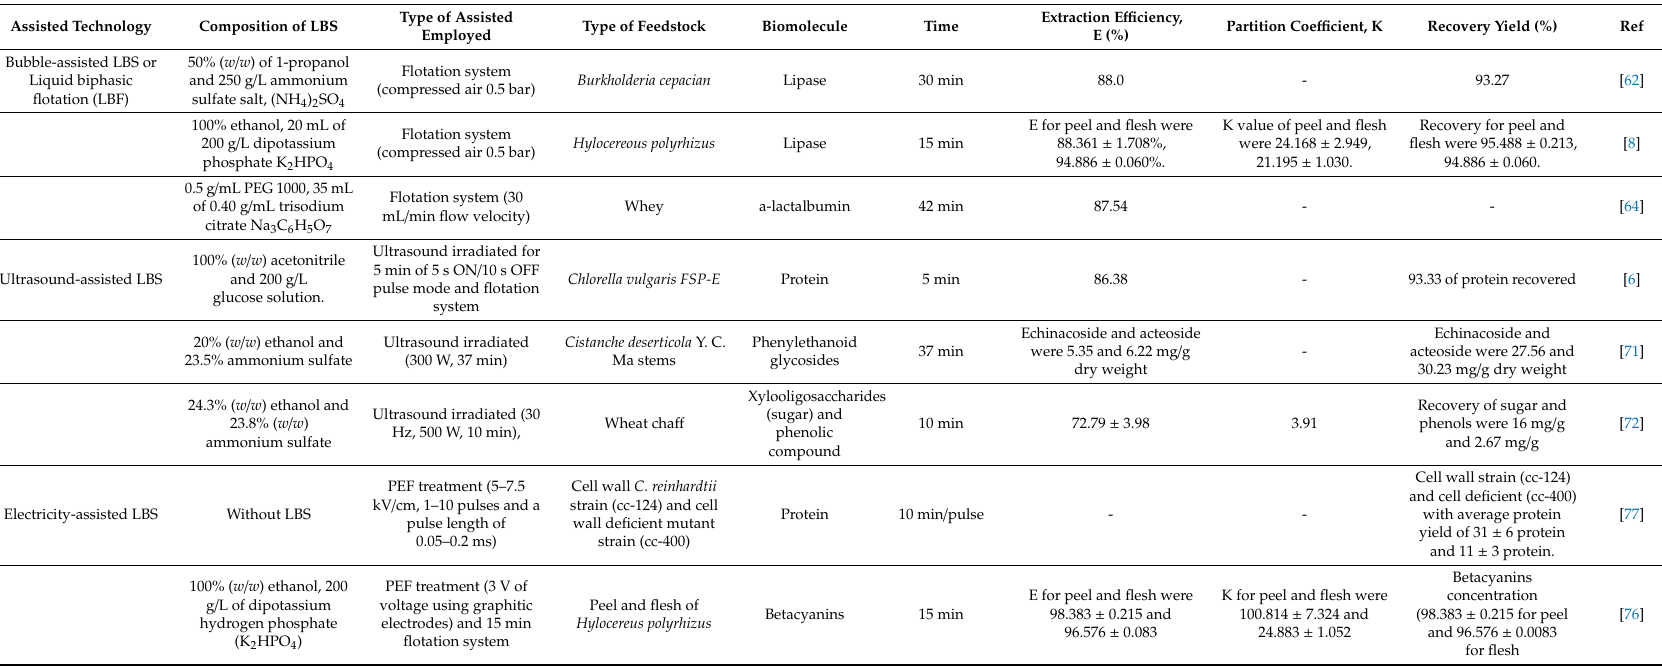
Table 2. Extraction of biomolecules using various types of advance technologies integrated in